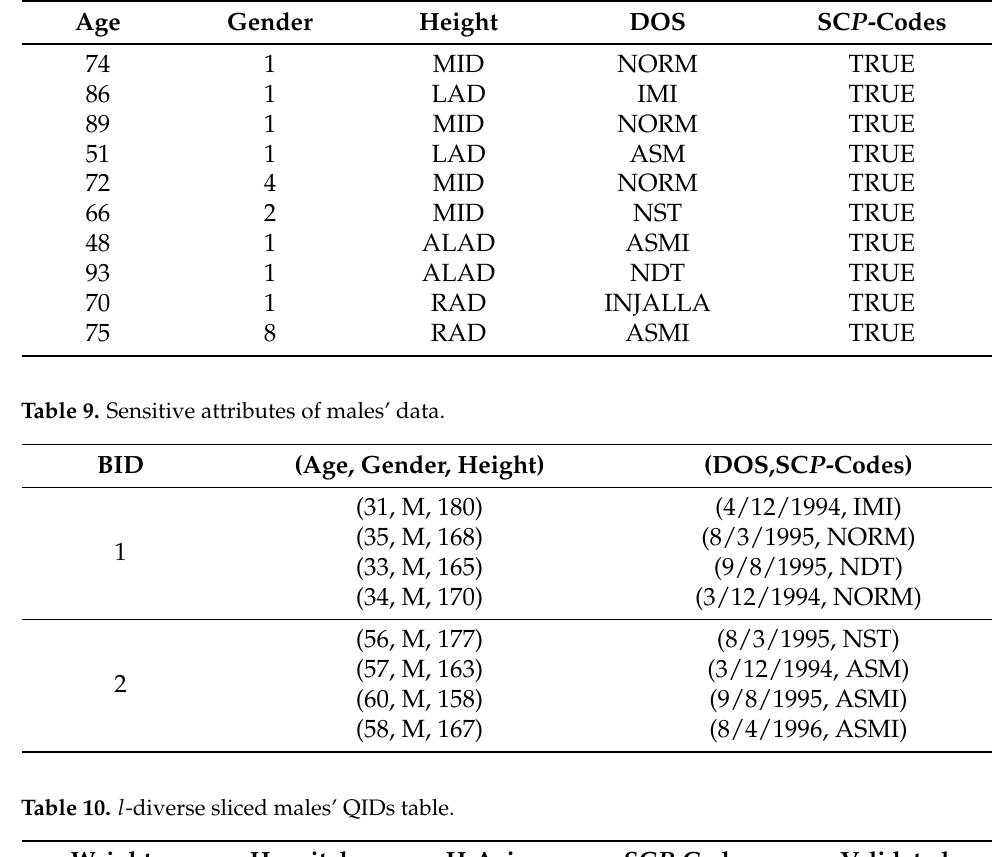
Table 8. QIDs of male data.